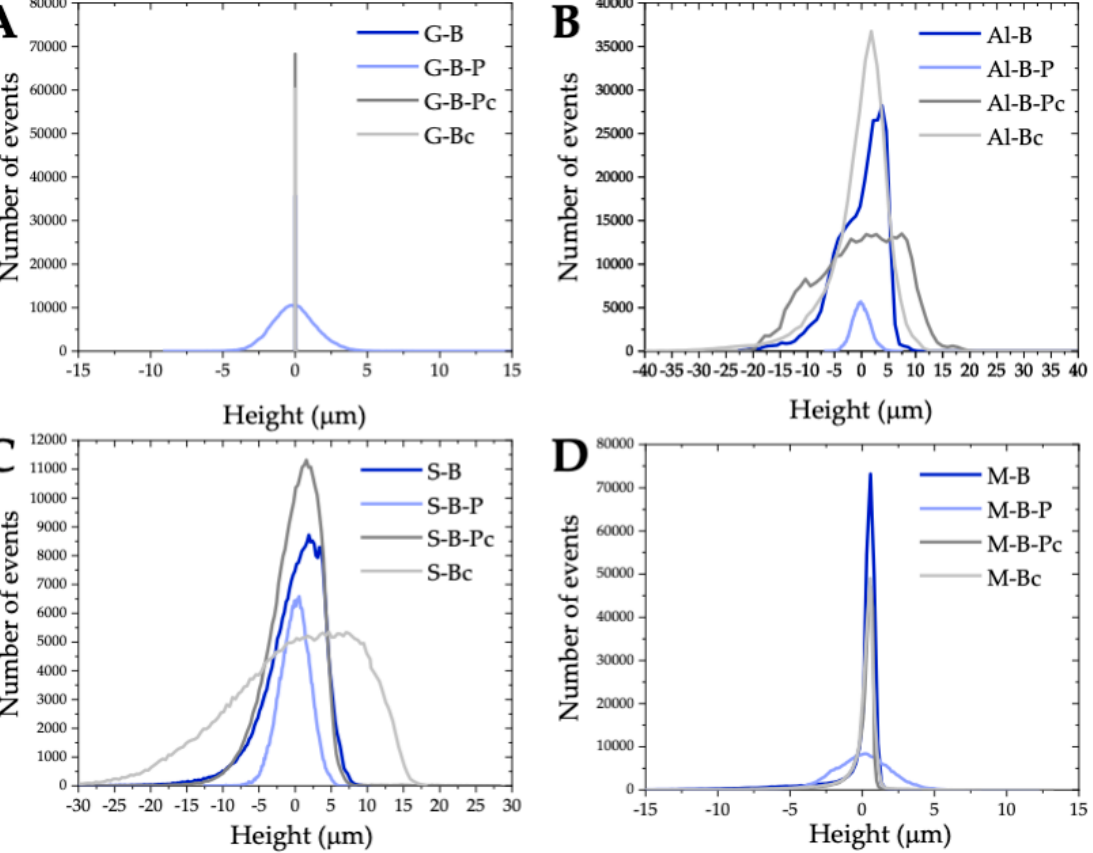
Figure 4. Roughness height distribution on the surfaces of glass ( A ), aluminum ( B ), stone ( C ) and marble ( D ) of the dimensions of 0.94 × 1.3 mm 2 .